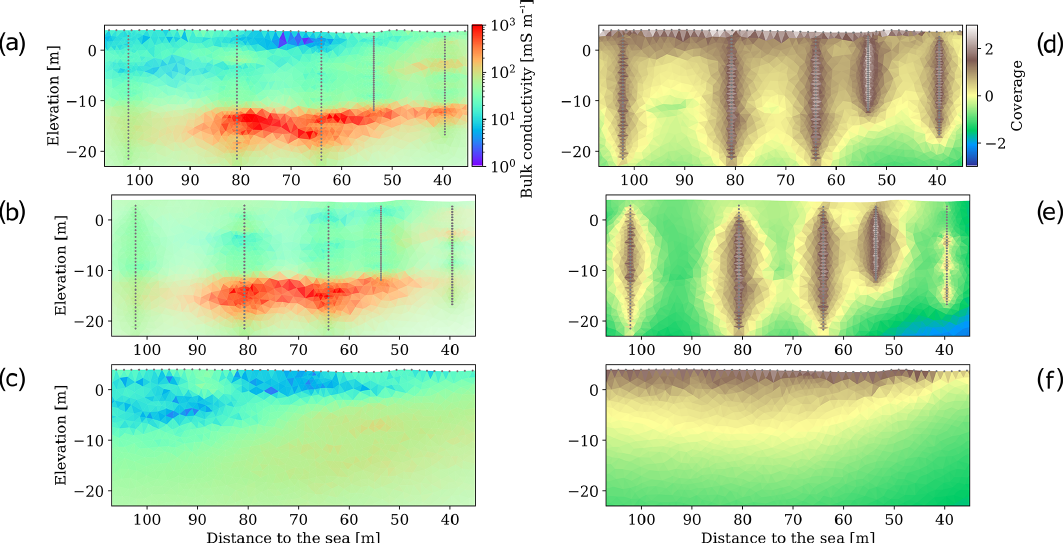
Figure 3. Bulk electrical conductivity models obtained by the inversion of the CHERT and surface-based ERT data (a) , the result when only considering the complete CHERT (b) and only the surface ERT (c) with the corresponding calculated coverages for each model (d–f) . The complete CHERT model shows conductive anomalies (in red), which are not shown by the surface ERT model. The inversion of both datasets combines the coverages and yields an image with higher resolution near the surface and at depth (d) .